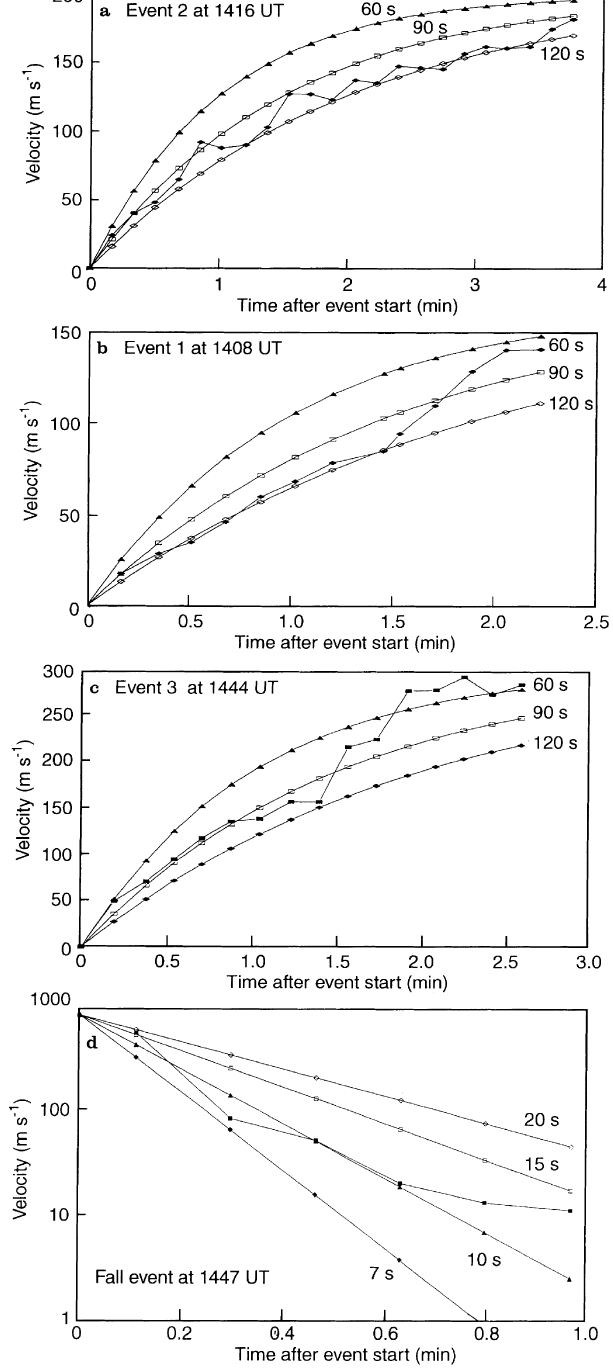
Fig. 4a–d. Line-of-sight velocity measurements, averaged over the 5 range gates shown in Fig.3, as a function of time since the start of the event. The way in which the line-of-sight velocity measurements have been averaged is described in the text. Exponential curves of the form V (cid:136) V o (cid:133) 1 (cid:255) e (cid:255) t = T (cid:134) are shown using three time constants, T (cid:136) 60 ; 90 and 120 s. a event 2 starting at 1416 UT, b event 1 starting at 1408 UT and c event 3 starting at 1444 UT. d Falling line-of-sight velocity measurement for interval immediately following event 3. Curves derived using the time constant curve V (cid:136) V o (cid:133) e (cid:255) t = T (cid:134) with T (cid:136) 7 ; 10 ; 15 and 20 s